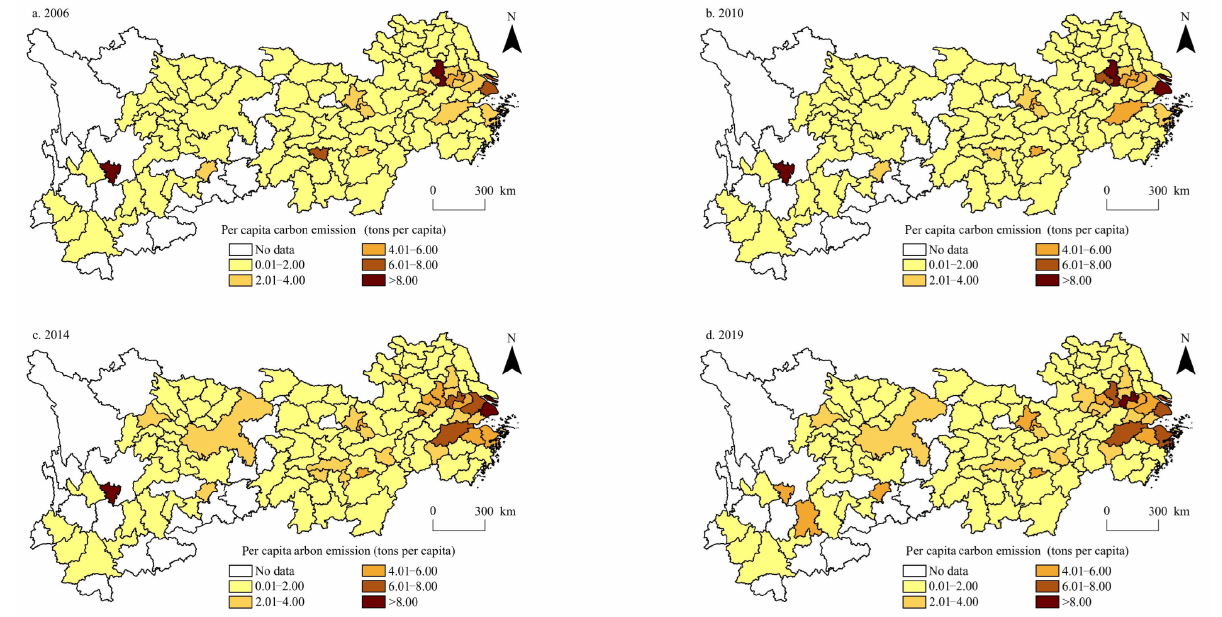
Figure 4. Spatial distribution pattern of per capita carbon emissions in the Yangtze River Economic Belt during 2006–2019.